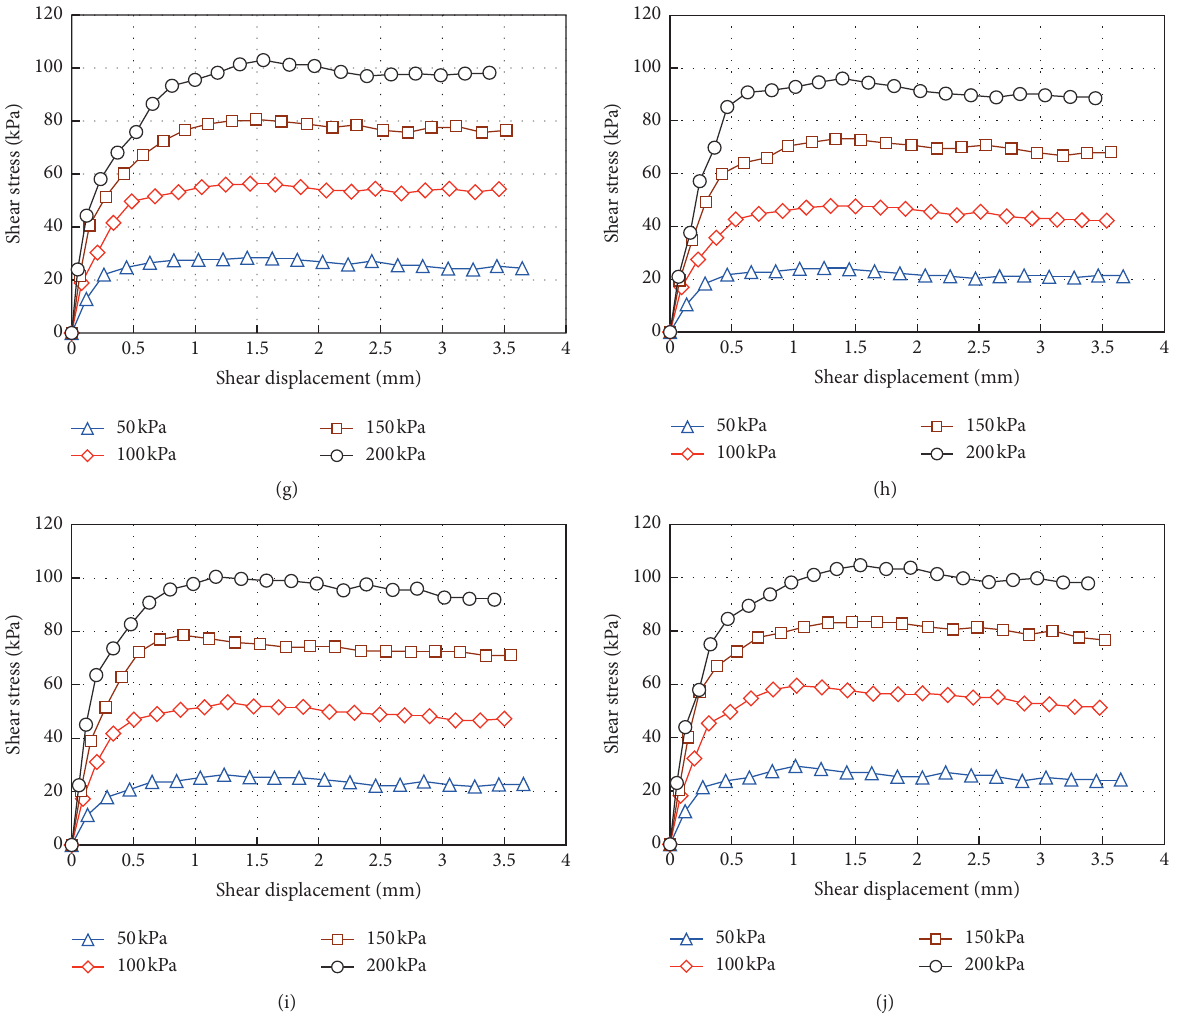
Figure 8: Shear stress-shear displacement curves for the steel-sand interfaces. (a) Int-A. (b) Int-B-0 ° . (c) Int-B-45 ° . (d) Int-B-90 ° . (e) Int-C-0 ° . (f) Int-C-45 ° . (g) Int-C-90 ° . (h) Int-D-0 ° . (i) Int-D-45 ° . (j) Int-D-90 °